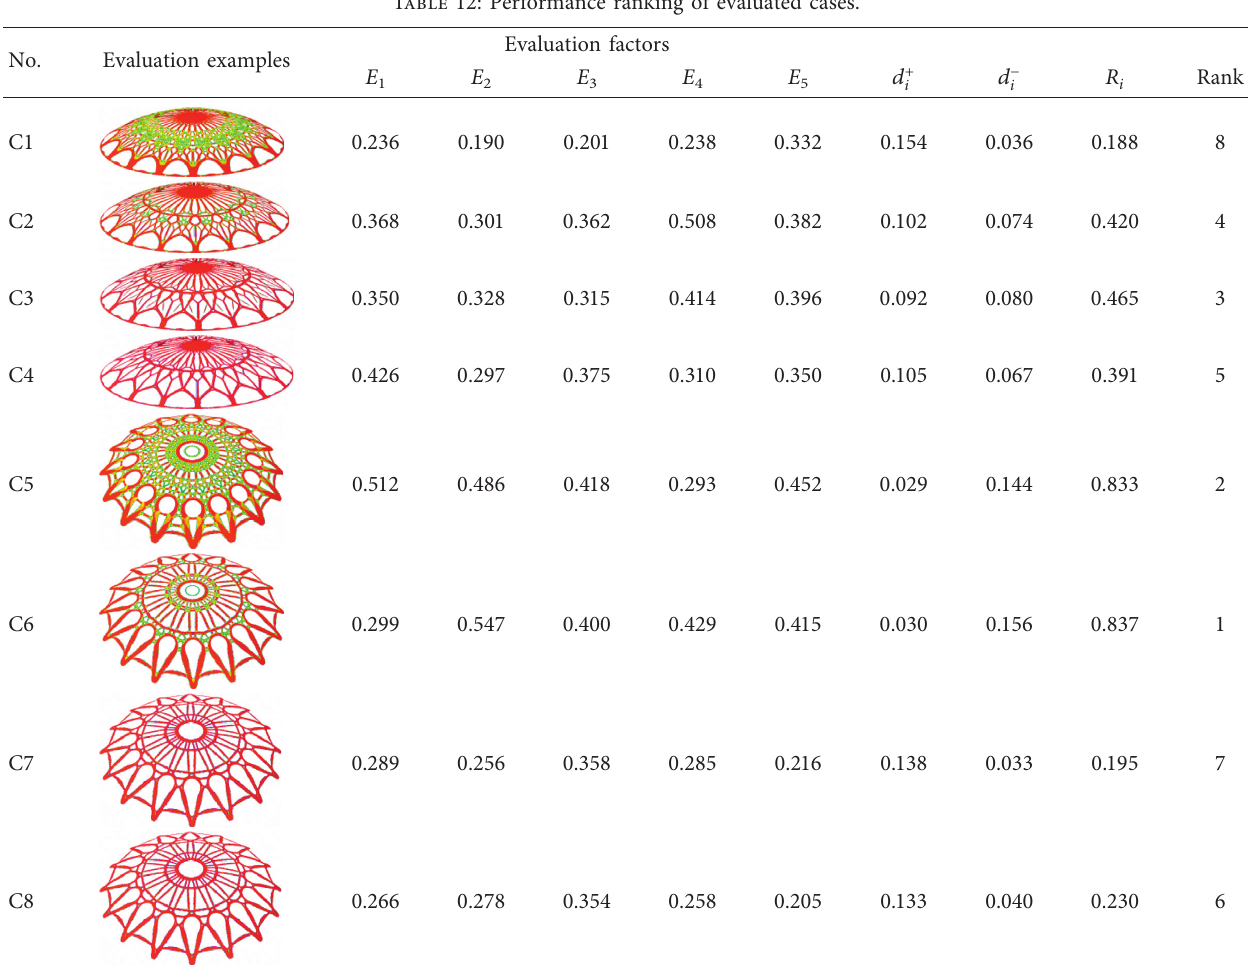
Table 12: Performance ranking of evaluated